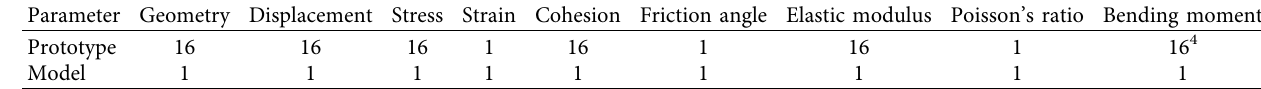
Table 2: Each of parameter for symmetry ratio.